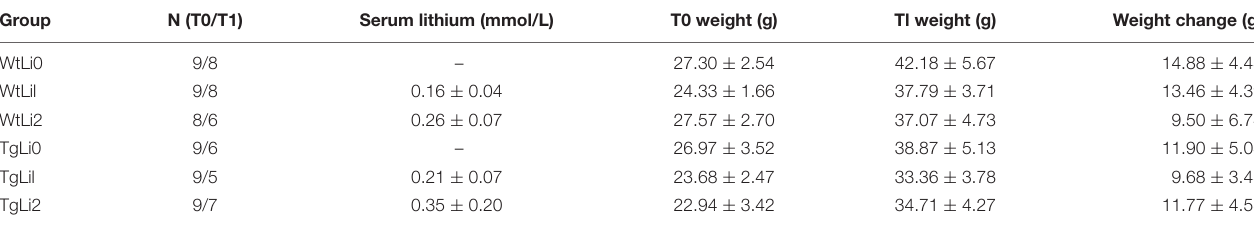
TABLE 1 | Characterization of study groups according to genetic characteristics of mice and intervention.